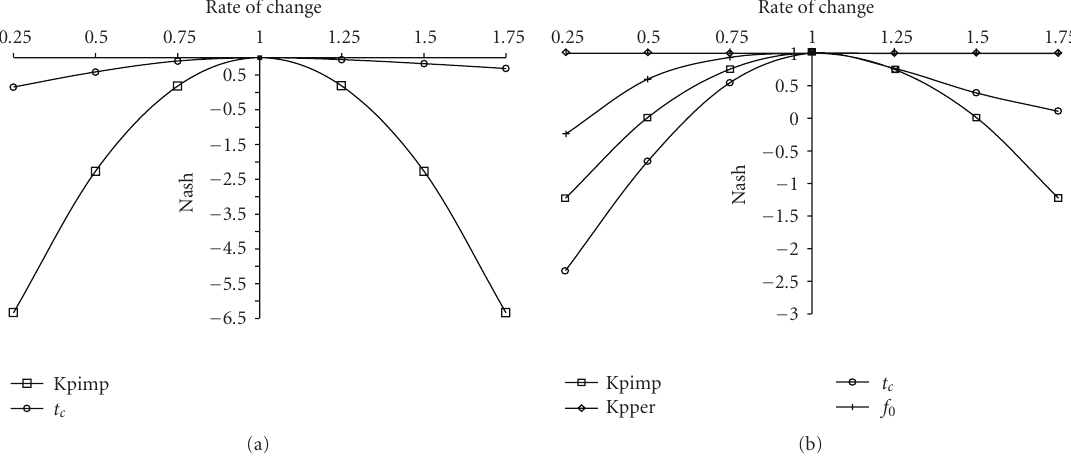
Figure 3: Variation of the Nash criterion with the rate of change of the RQSM parameters for (a) rainfall (1) and (b) rainfall (2).